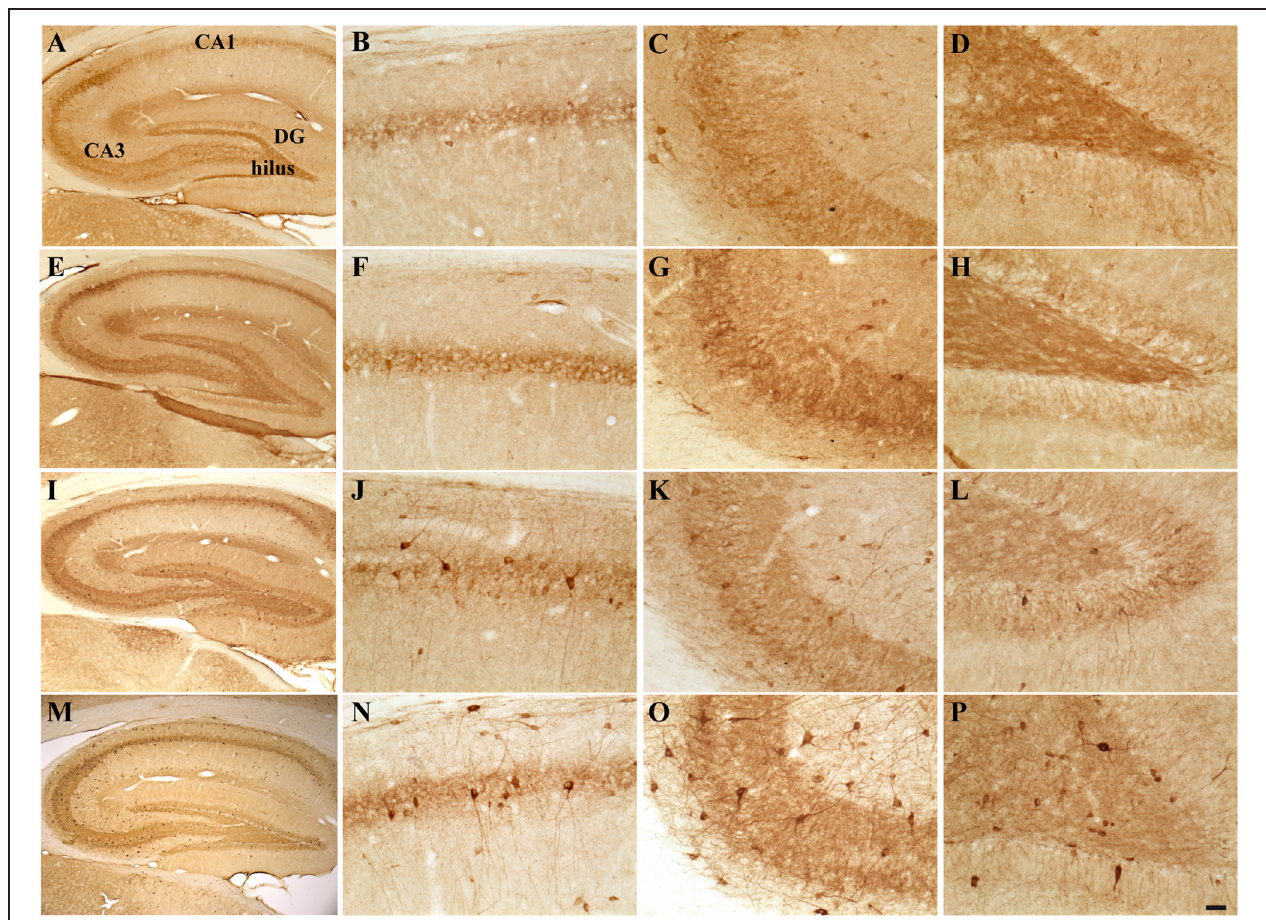
FIGURE 4 | Hippocampal distribution of glutamic acid decarboxylase 67 (GAD67)-immunoreactive interneurons in the different experimental groups. Representative micrographs of GAD67-stained hippocampal sagittal sections from the whole hippocampus (A,E,I,M) , CA1 (B,F,G,N) , CA3 (C,G,K,O) and hilus (D,H,L,P) of CTRL + oil- (A–D) , CTRL + E2- (E–H) , TMT + oil- (I–L), and TMT + E2- (M–P) treated rats. A higher number of GAD67-IR cells is evident in the CA1 pyramidal layer (J,N) and in the hilus (L,P) of both TMT-treated groups. GAD67 expression also appears markedly increased in the CA1 stratum oriens (N) , in the CA3 pyramidal layer (O) , in the DG and in the hilus (P) of TMT + E2-treated animals compared with all other groups. A darker staining of GAD67-IR neurons is evident in both groups of TMT-treated animals (I,L,M,P) . Scale bar: 200 μ m in (A,E,I,M) ; 50 μ m in (B–D,F–H,J–L,N–P) .